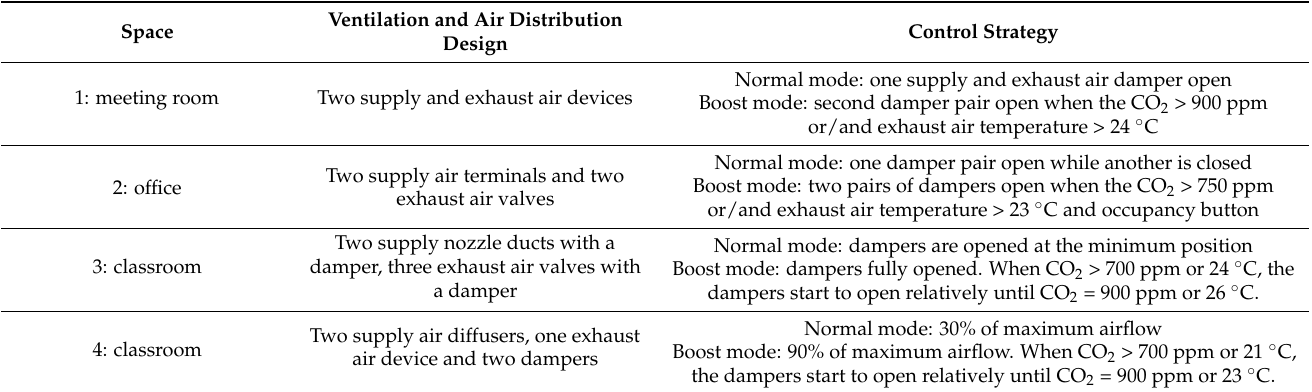
Table 3. Ventilation and air distribution design and control strategies for Type 1 spaces.